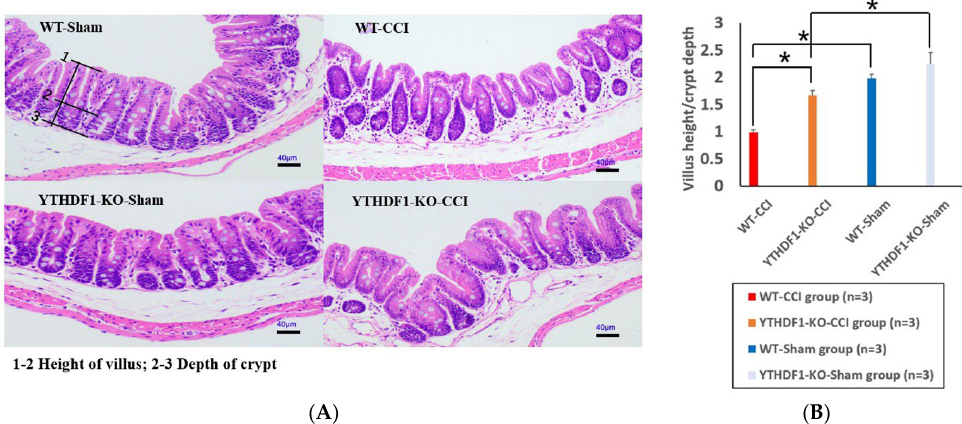
with the WT group, the inflammatory protein CD68 significantly decreased, forkhead box P3 (FOXP3) markedly increased (Figure 3B), and the oedema protein aquaporin 4 (AQP4) notably decreased, while claudin5 markedly increased (Figure 3C) in the YTHDF1- knockout group.